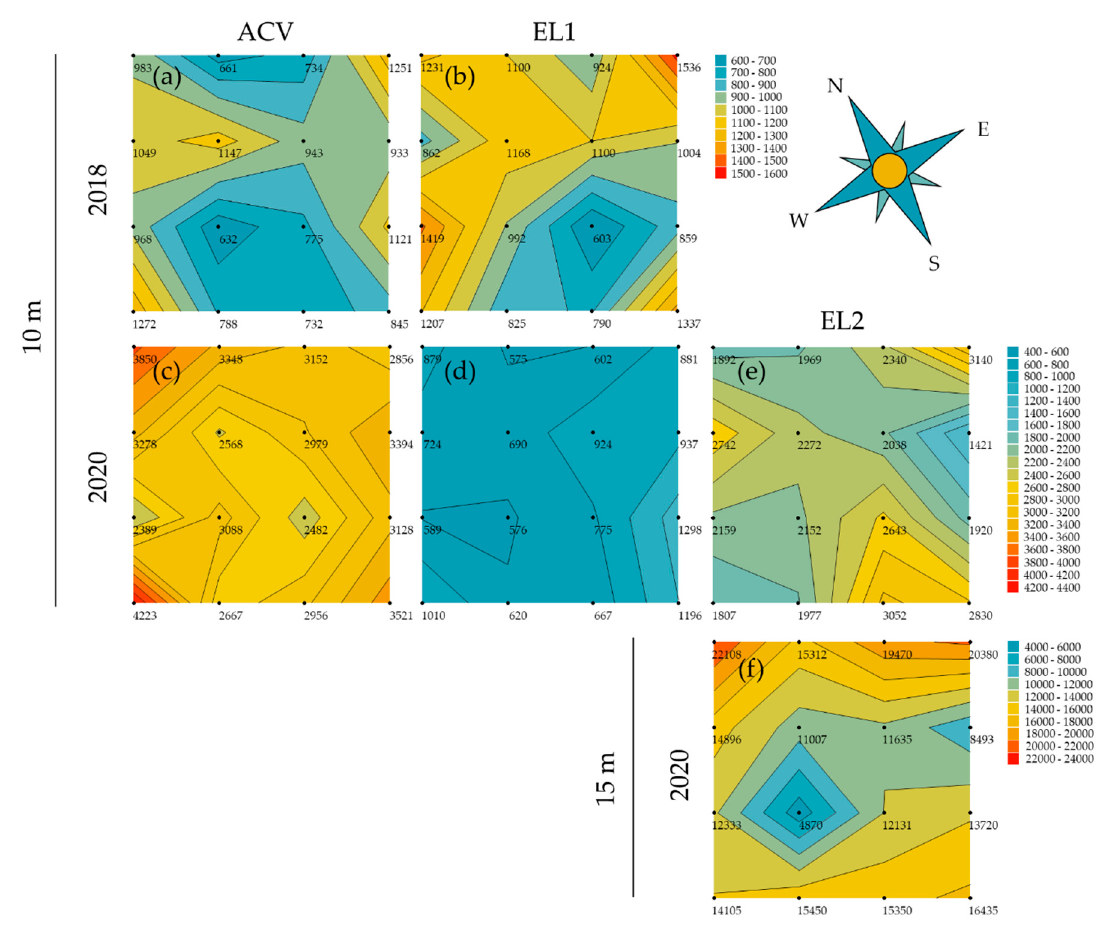
Figure 5. Contour plots for the trials in summer at 10 and 15 m inter-trap spacing. Each point of the 4 × 4 grids represents the pooled D. suzukii (male and female) trap catches for a trap position over the whole trial period (August/September) and the four replicate grids. The contour plots for ( a ) ACV and ( b ) EL1 in 2018 both show a similar depression in the southwestern centre trap positions. For EL1, there is a pattern of peaks on the corner trap positions; for ACV this is less evident. The mean wind direction in this period was SSW. In 2020, the contour plot of ( c ) ACV shows a depression in the centre and peaks on the corner trap positions. This pattern is not as clear for ( d ) EL1 and absent for ( e ) EL2. Mean wind direction during the corresponding period was SW. ( f ) The plot for EL2 at 15 m inter-trap spacing shows a clear depression in the centre with peaks on the corner trap positions. The mean wind direction was SSE during this trial.